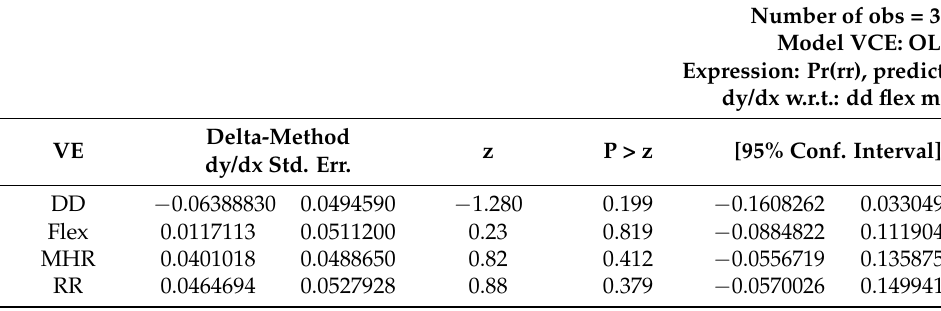
Table 7. Marginal effects with VE as dependent